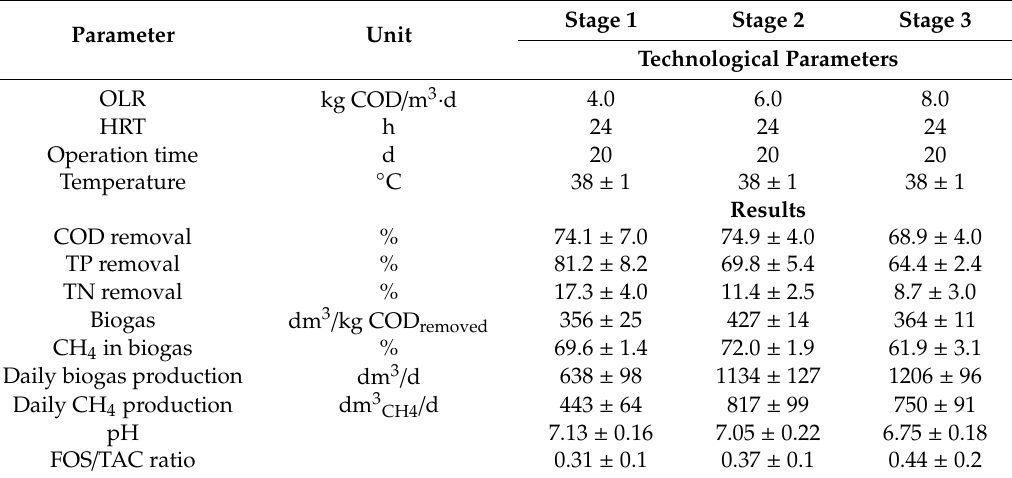
Figure 3. Changes in the chemical oxygen demand (COD), in the treated e ffl uent. Table 6. Performance characteristics of the